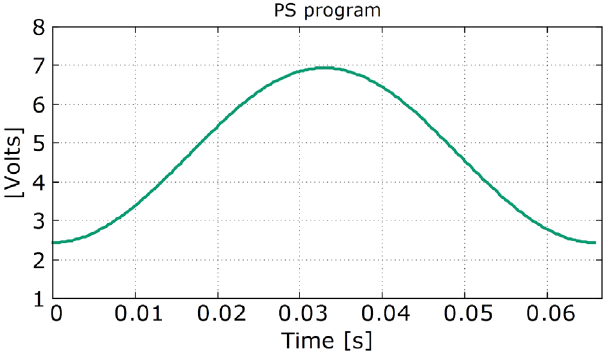
FIG. 2. A single 15 Hz cycle of the power supply program voltage, from one minimum to the